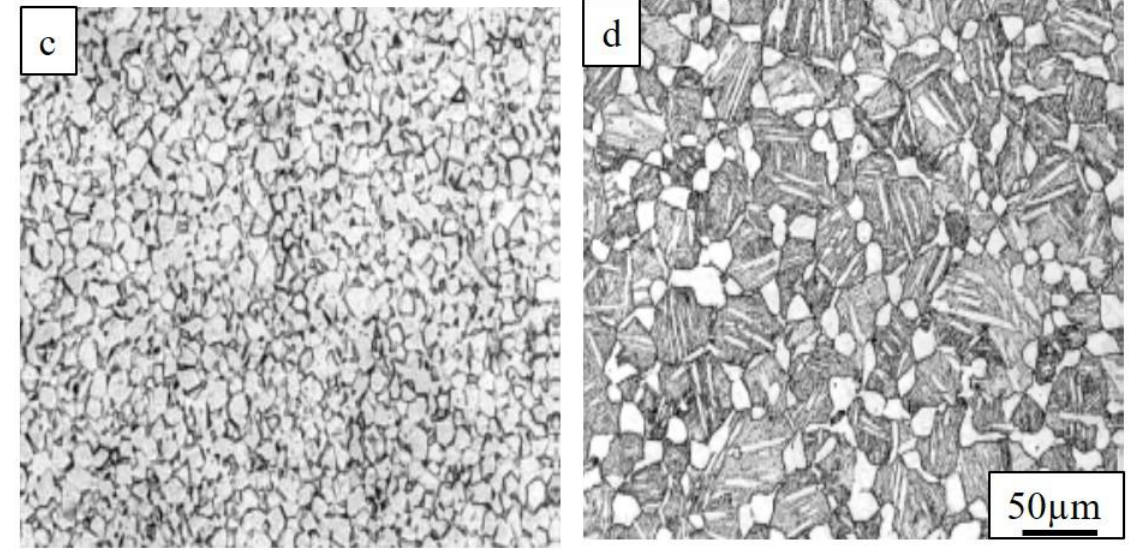
Figure 1. Example of ( a ) lamellar, ( b ) acicular, ( c ) equiaxed, and ( d ) bi-modal microstructure in Ti6Al4V alloy [4,6].